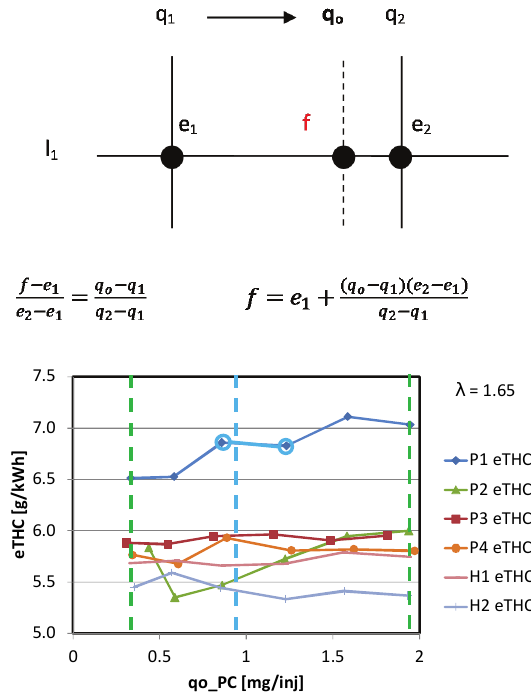
Fig. 11. Determination of emission values for internal fuel dose points qo_PC intervals: a) example of linear interpolation, b) example analy- sis points For the extrapolated and interpolated data the optimiza- tion procedure described in chapter 8 was performed (Fig.